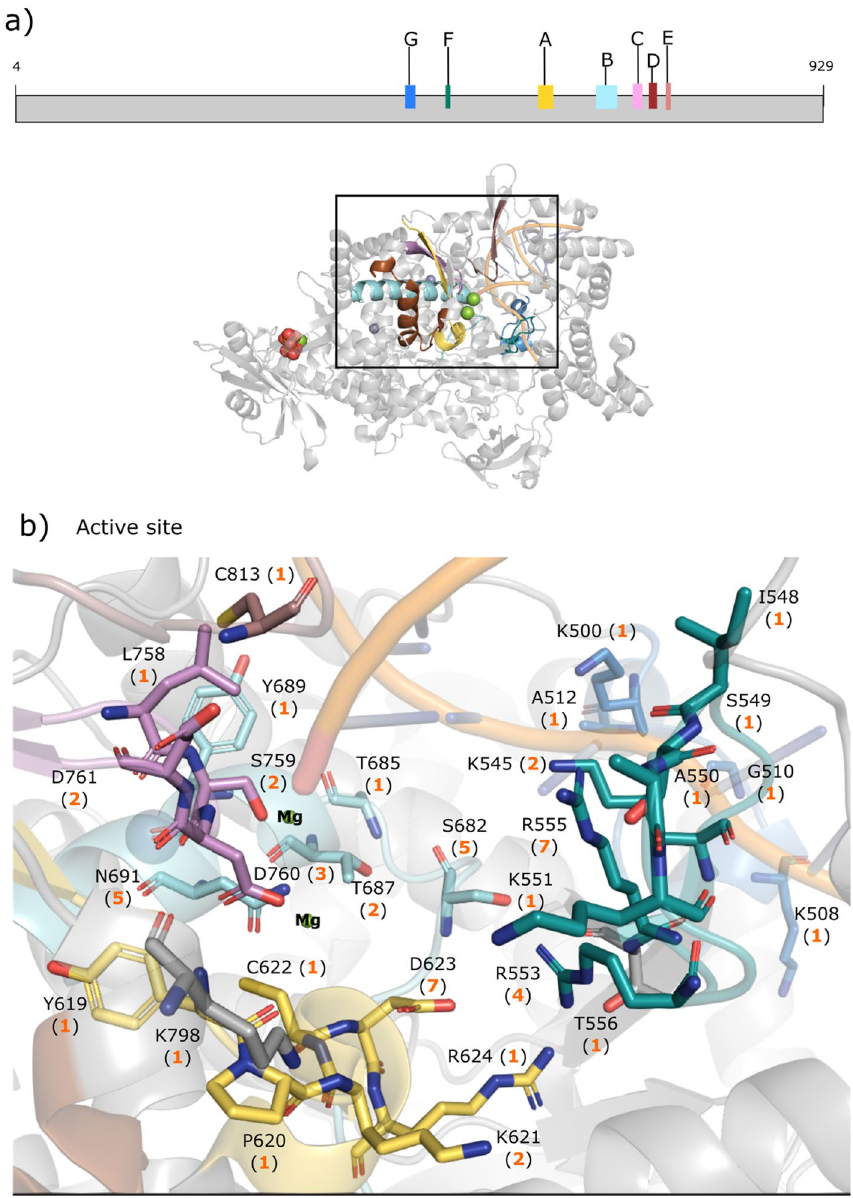
Figure 5. SARS-CoV-2 RdRp domain structure and binding sites. ( a ) Diagram showing the seven conserved motifs (A–G) in nsp12 and the cryo-EM structure (PDB 7aap). ( b ) The inset shows the number of drugs (in parentheses) targeting a residue belonging to one of the 7 conserved motifs (A–G) 58